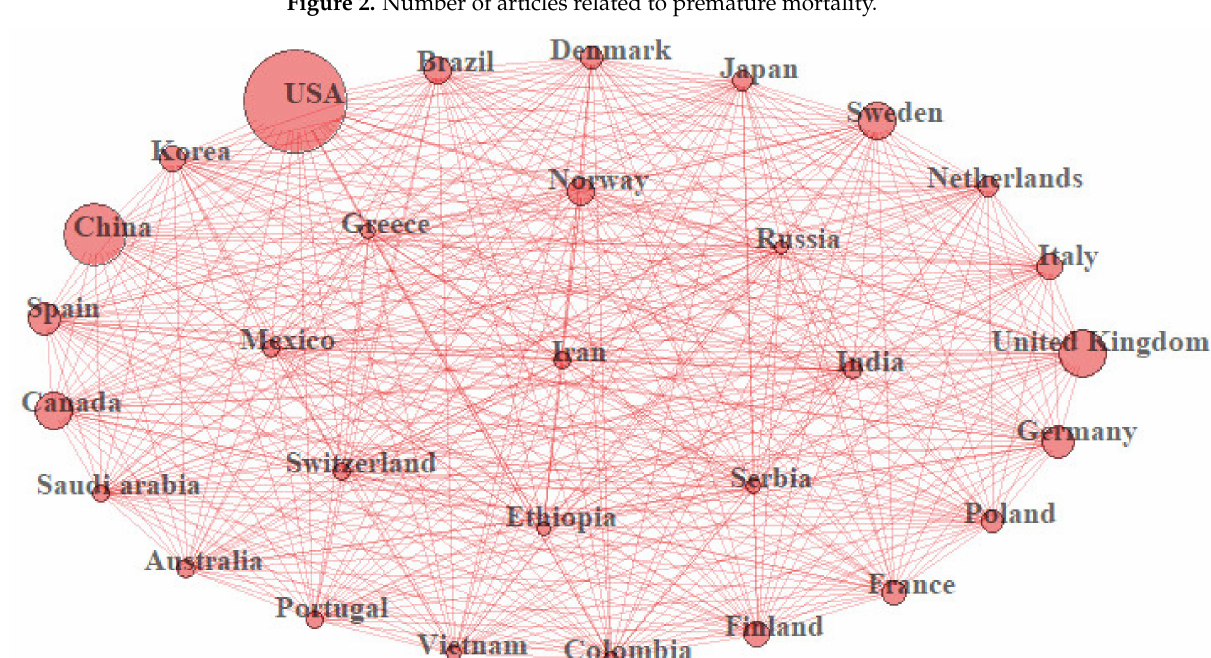
Figure 3. Collaboration of countries publishing articles related to premature mortality. Note: The size of the circles represents the number of collaborations with other